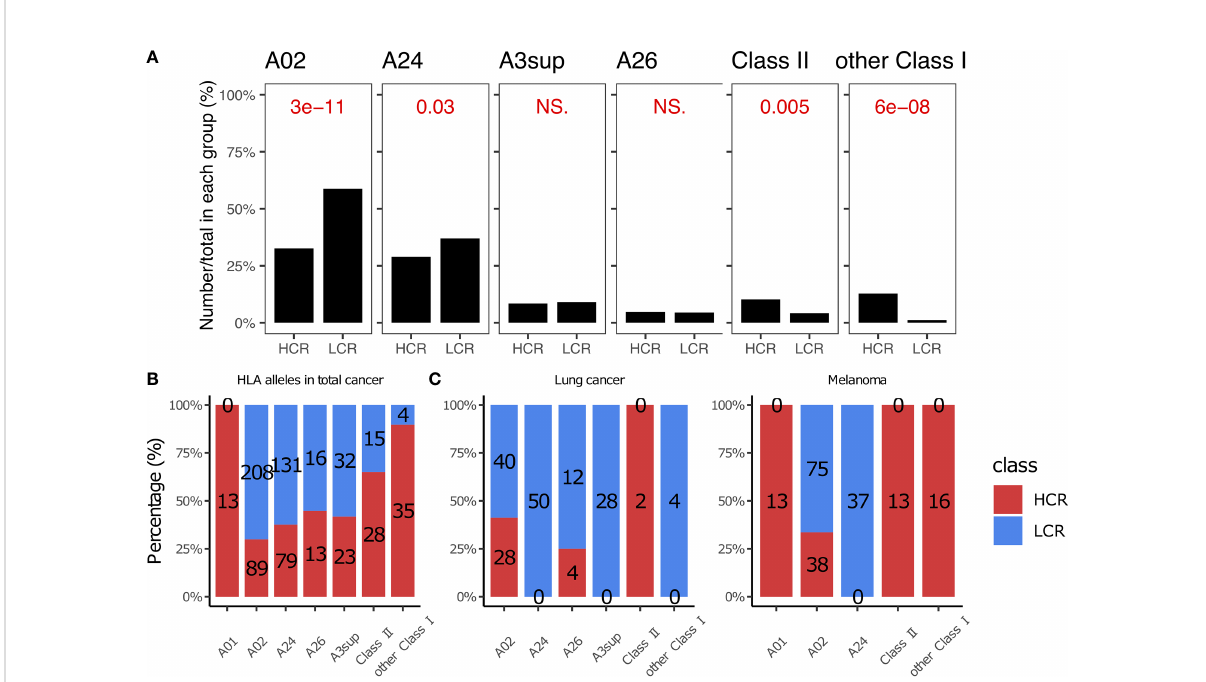
FIGURE 4 HLA alleles in high and low clinical response results. (A) Comparison of HLA alleles between HCR and LCR results. (B) The distribution of HLA alleles in HCR and LCR results. (C) The distribution of HLA alleles in HCR and LCR results in melanoma and lung cancer, respectively. P-values were calculated using two-sided Wilcoxon rank-sum tests. NS, not signi fi